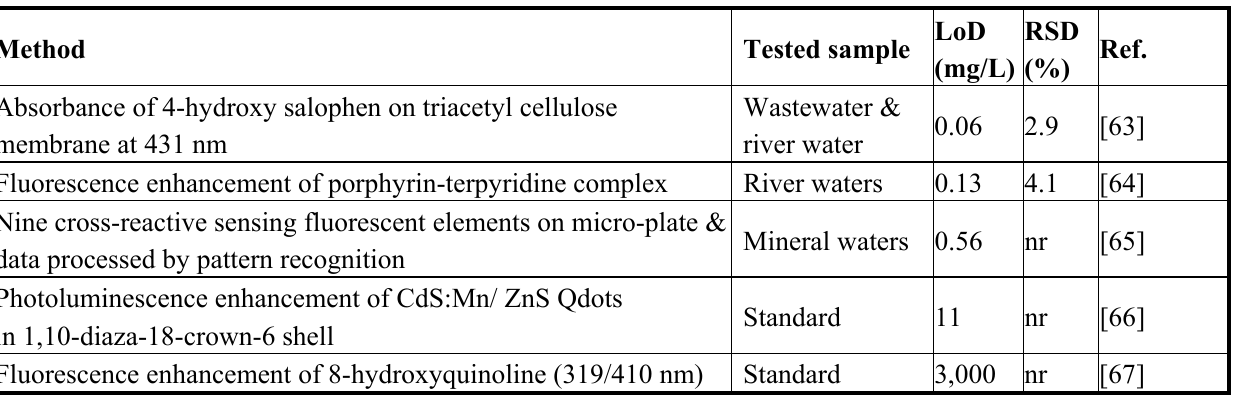
Fluorescence enhancement of 8-hydroxyquinoline (319/410